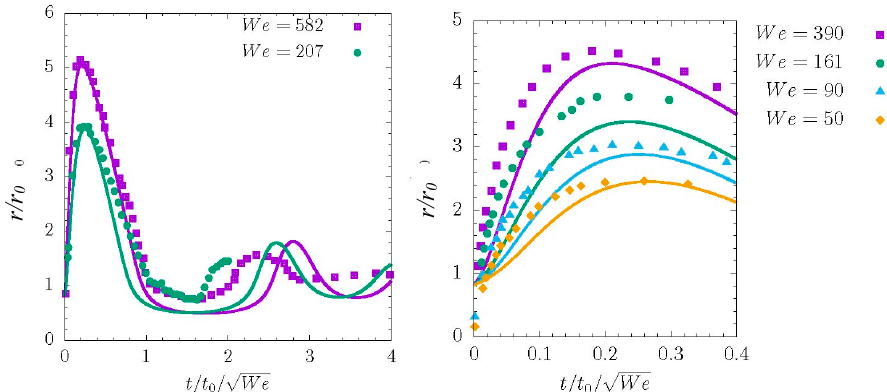
Figure 2. Droplet base radius r evolution in time: symbol: experimental data, lines: computed values. Left, 𝜃 𝑠 = 87° , Re = 588 · We 0.5 ; right, 𝜃 𝑠 = 100° , Re = 454 · We 0.5 .